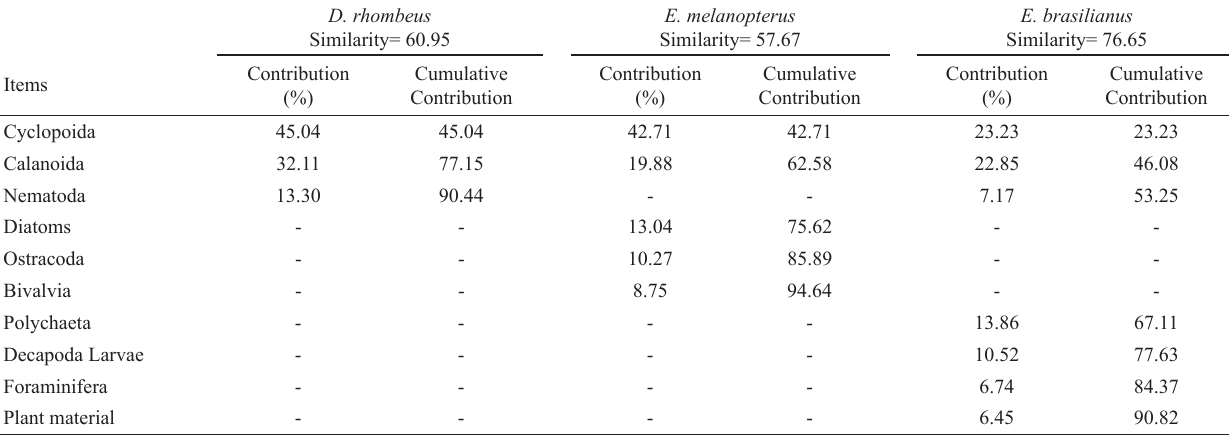
Table 6. Similarity values and Contribution (%) obtained by the SIMPER analysis for percentage volume values of feeding items used by Diapterus rhombeus , Eucinostomus melanopterus and Eugerres brasilianus in the rio Mamanguape estuary, northeastern